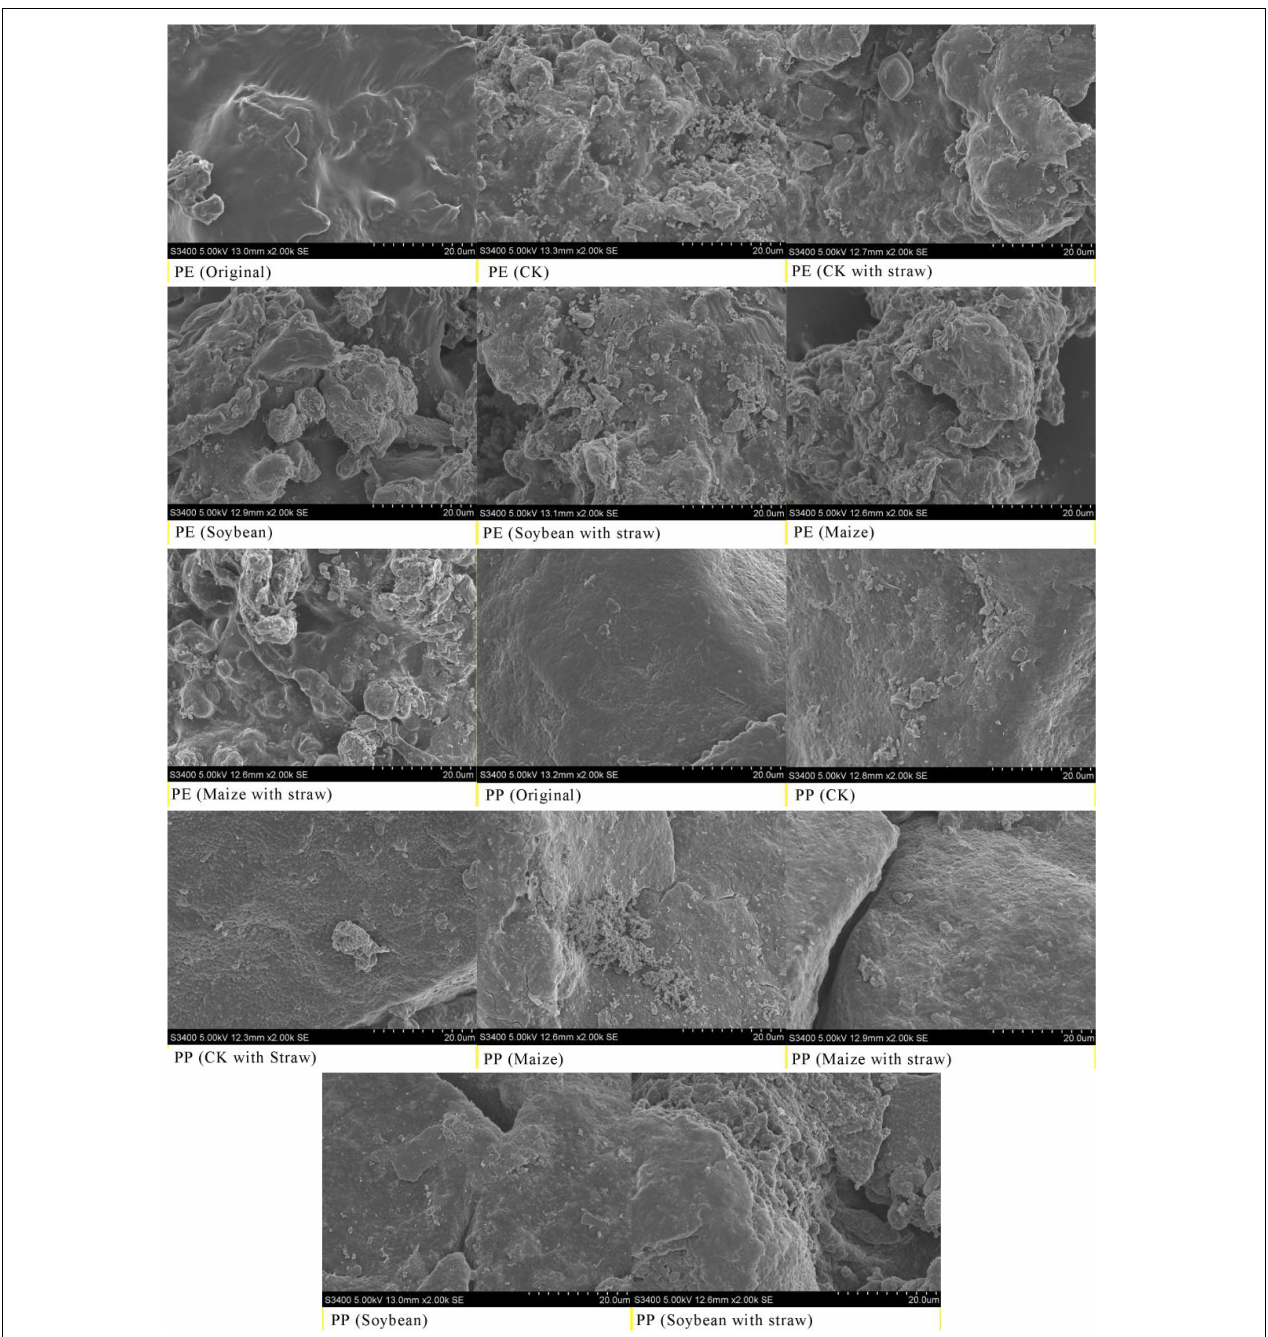
FIGURE 2 | Surface morphology of low-density polyethylene (LDPE) and low-density polypropylene (LDPP) was changed before and after soybean ( Glycine max ) growth, maize ( Zea mays ) growth, and straw amendment. Images were taken by a scanning electron microscope (SEM, Hitachi, S3400). CK was the control treatment with no crop growth; the original was LDPE-MPs and LDPP-MPs without any treatment. Here, only treatments of 1% LDPE and LDPP are